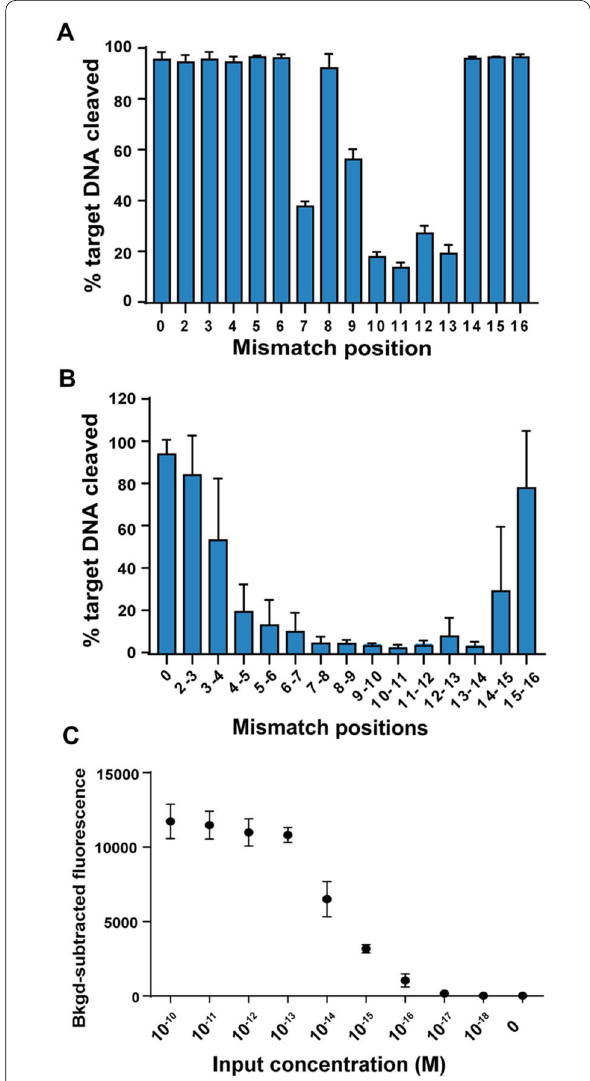
Fig. 3 The specificity and sensitivity of RADAR detection. Observed activity for Pf Ago using a fluorophore-labeled ssDNA with the indicated single nucleotide mismatches ( A ) and di-nucleotide mismatches ( B ). Pf Ago cleavage kinetics of ssDNA targets were measured, and the cleavage activity at the 20 min time point was plotted against the mismatch position. Ratios represent the average of three different targets measured in triplicate, and error bars represent mean s.d., where n 9 (three replicates for three ± = independent targets. C Detection sensitivity of the RADAR system using diluted plasmids. Error bars represent the mean s.d., n ± =